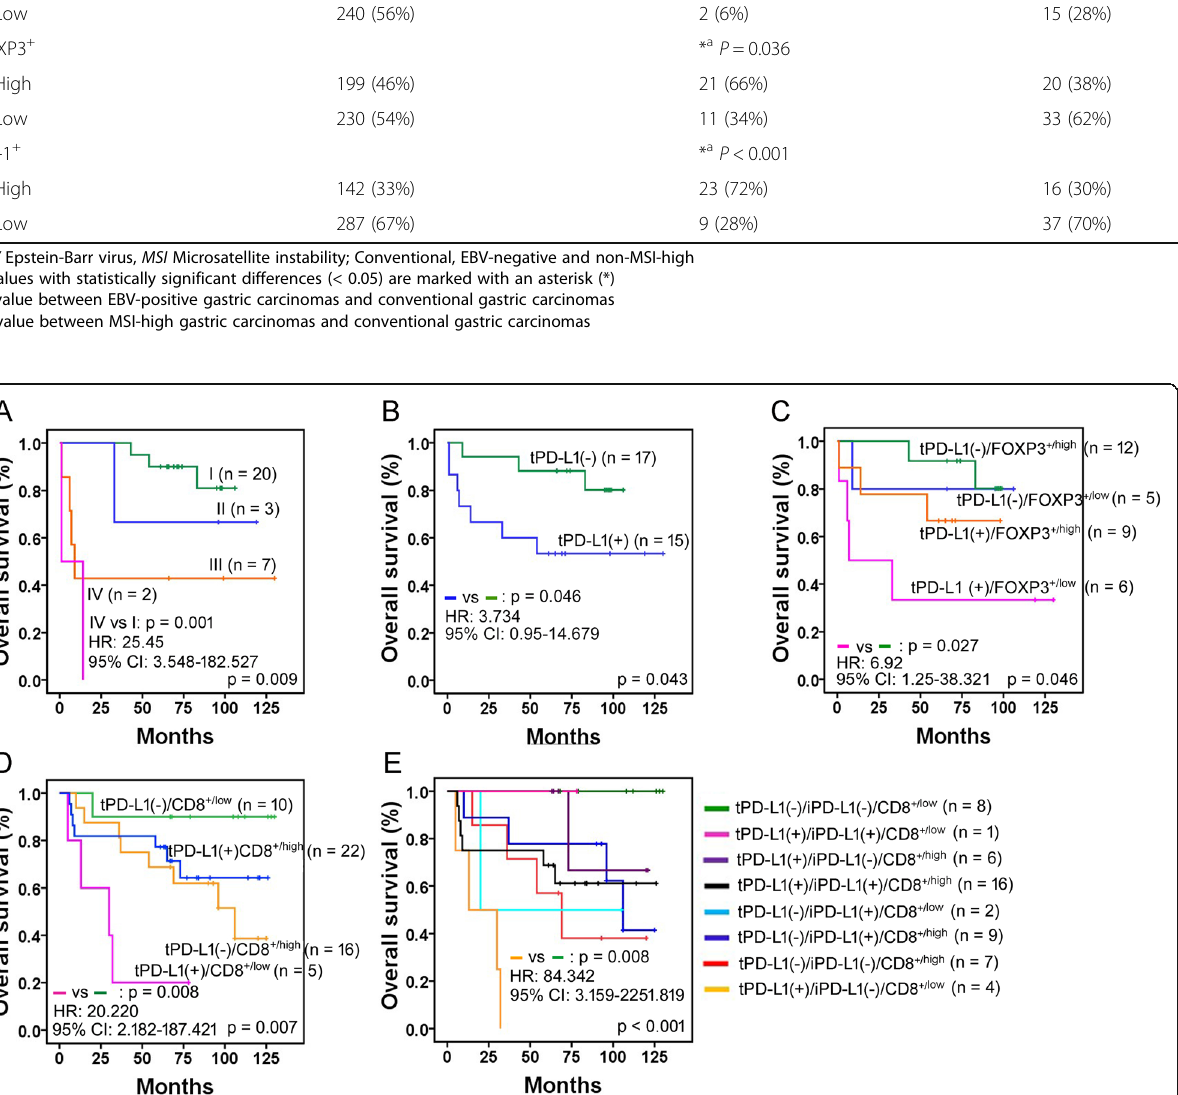
Fig. 4 Kaplan-Meier plots of overall survival in EBV-positive or MSI-high gastric carcinomas. a - c In EBV-positive gastric carcinomas ( N = 32), more advanced-stage tumors ( a ), tumoral PD-L1(+) ( b ), and the combined subset of tumoral PD-L1(+)/FOXP3 +/low TILs ( c ) are associated with lower rates of patient survival. I, II, III and IV in ( a ) indicate TNM tumor stage. d - e In MSI-high gastric carcinomas ( N = 53), the combined subsets of tumoral PD-L1(+)/CD8 +/low TILs ( d ) and tumoral PD-L1(+)/immune cell PD-L1( − )/CD8 +/low TILs ( e ) show a worse overall survival rate. Corresponding P value, hazard ratio (HR) and 95% confidence interval (CI) in the worst prognostic subset are shown in the bottom left corner of each plot, and P values throughout all subsets, in the bottom right corner of each